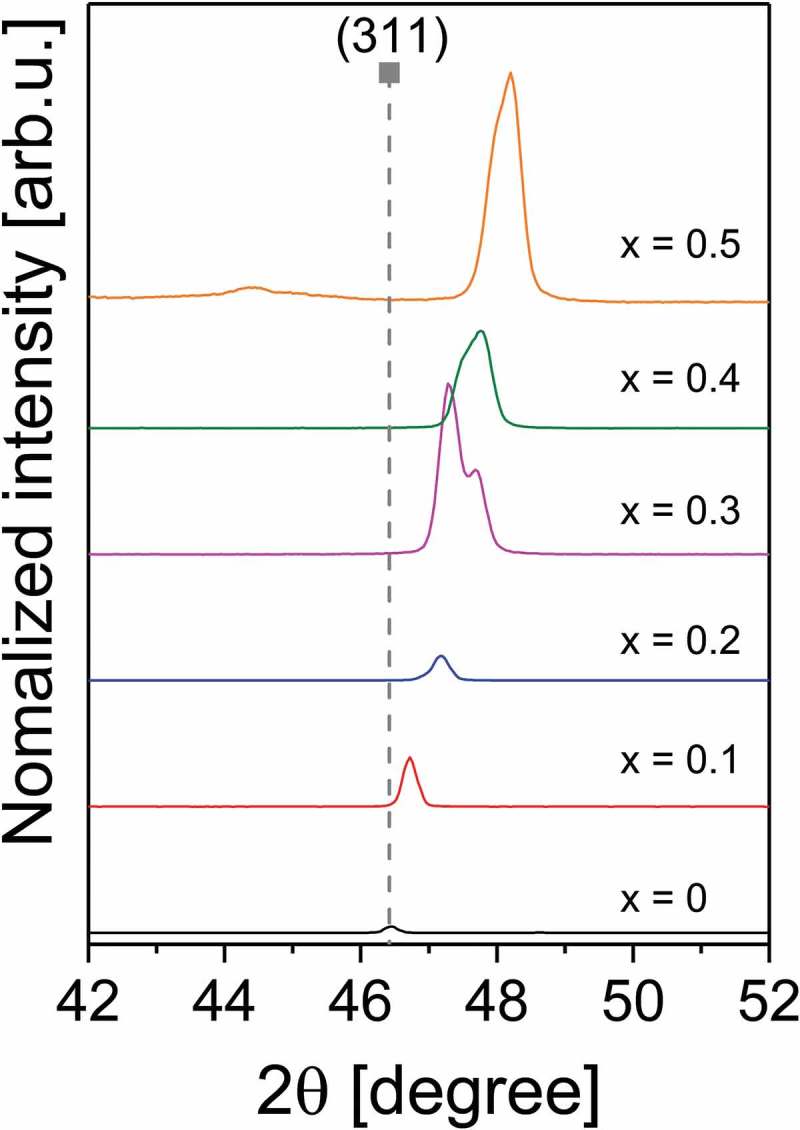
Splitting of the 311 Bragg reflex of CdTe1-xSex thin films on glass substrate. The reference value for the CdTe peak is from [18].